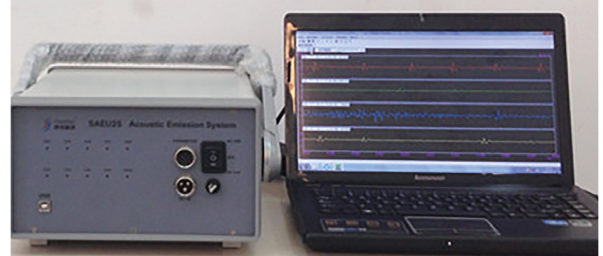
Figure 2: AE testing